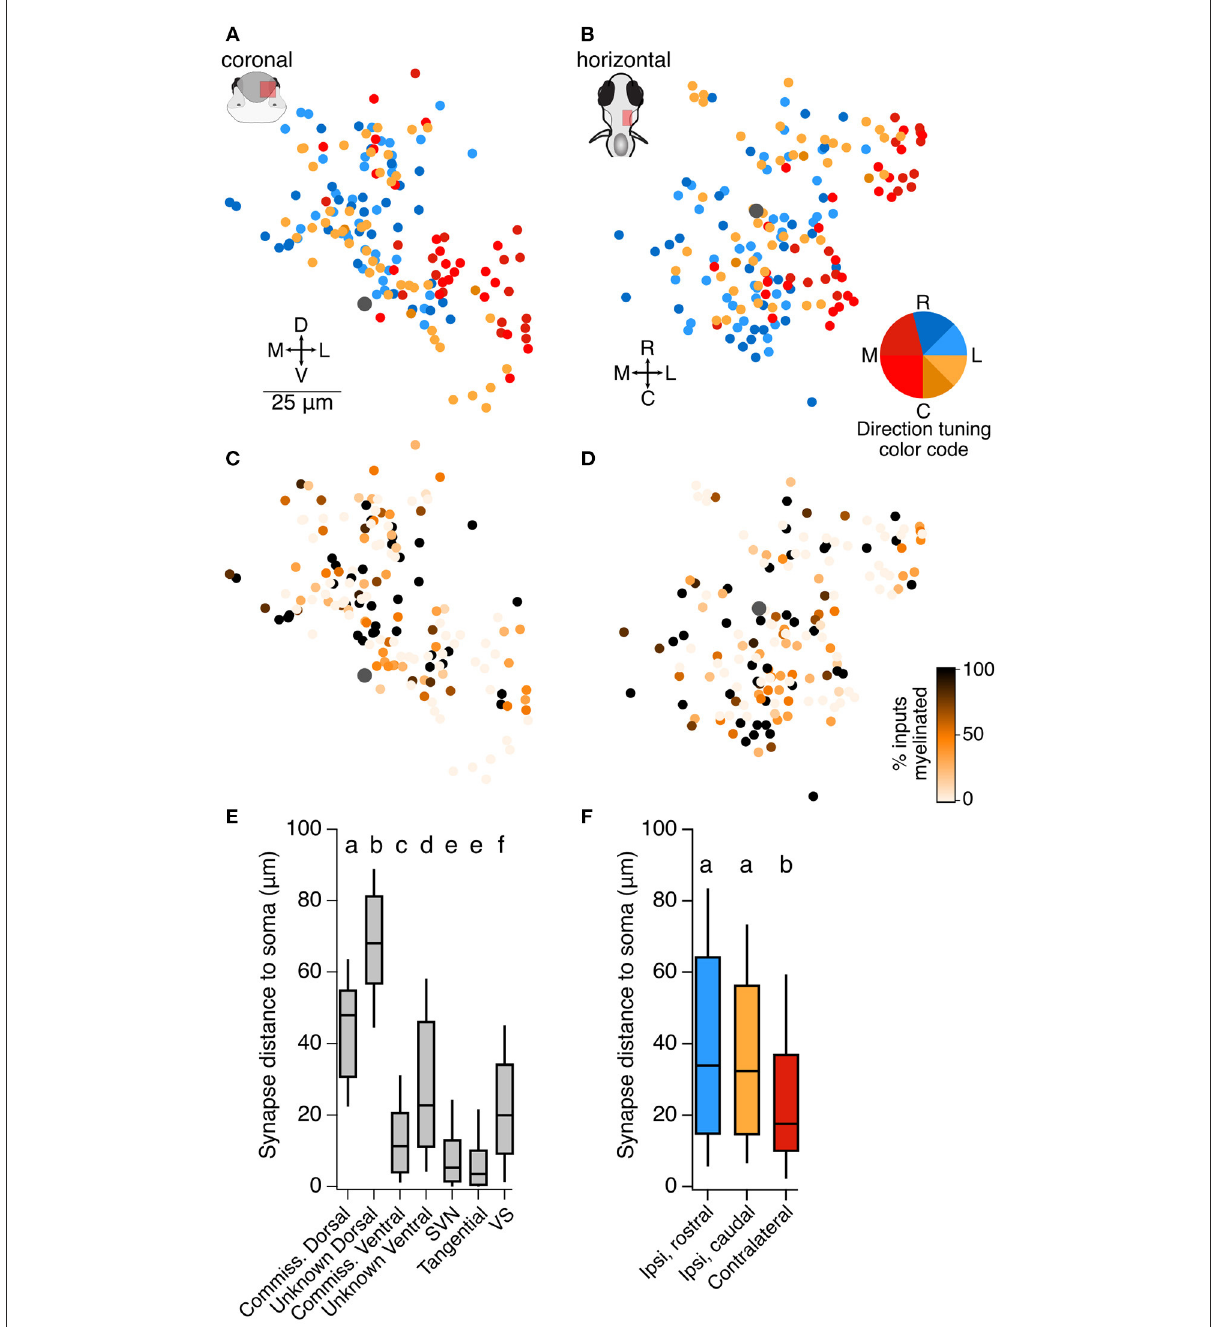
FIGURE7 Organization of central utricular neurons by inferred directional tuning. (A) Summary of the inferred directional tuning of all neurons described here in the coronal plane. The Mauthner cell body is indicated by a large gray dot. Neurons predicted to respond to contralateral tilt (reds) are on average located more laterally than those responsive to ipsilateral tilt, Wilcoxon-Mann-Whitney test, p = 1.0 × 10 − 9 . (B) As in (A) , in the horizontal plane. Neurons predicted to respond to contralateral tilt are on average located more ventrally, Wilcoxon-Mann-Whitney test, p = 0.007. (C) Summary of the fraction of inputs that arise from myelinated vs. unmyelinated utricular afferents for all neurons described here. Darker colors represent more input from myelinated afferents (scale in D ). Mauthner cell is indicated by a large gray dot. There is no apparent spatial organization of neurons receiving more or less myelinated input, although central neurons with myelinated axons receive more input from myelinated afferents (see Discussion). (D) As in (C) , in the horizontal plane. (E) The average distance of utricular synaptic contacts from the soma, measured along the dendrite, for each of the classes of neurons described here. Dorsally located somata receive utricular synaptic input at a longer distance from the soma than ventrally located somata of the same class (compare commissural dorsal and ventral neurons,